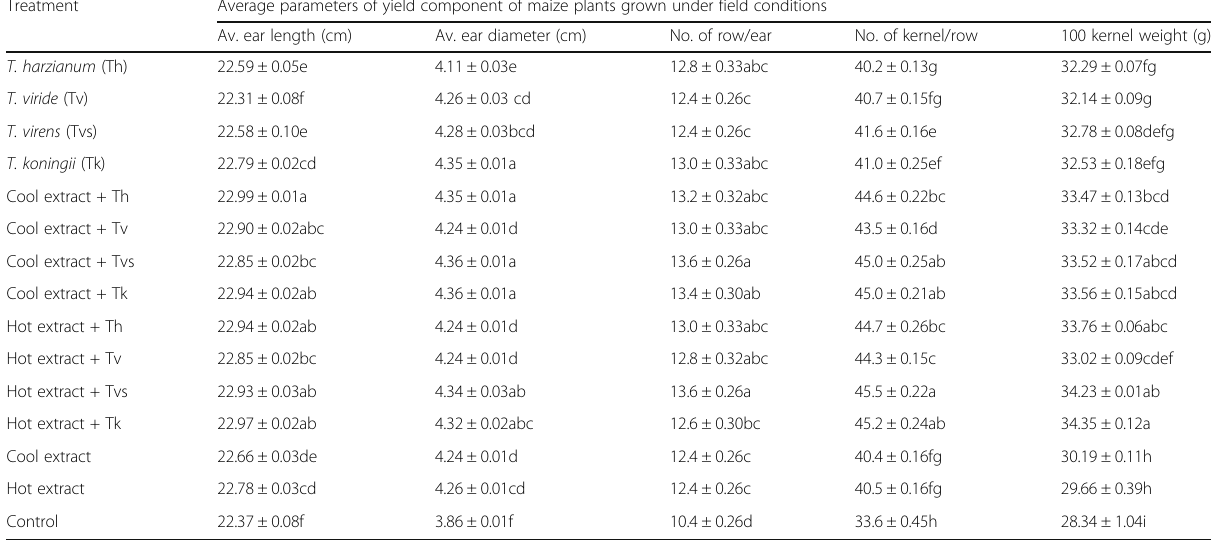
Table 7 Effect of Trichoderma spp. alone or in combination with Chlorella vulgaris extract on average parameters of yield component of maize plants grown under field conditions Treatment Average parameters of yield component of maize plants grown under field